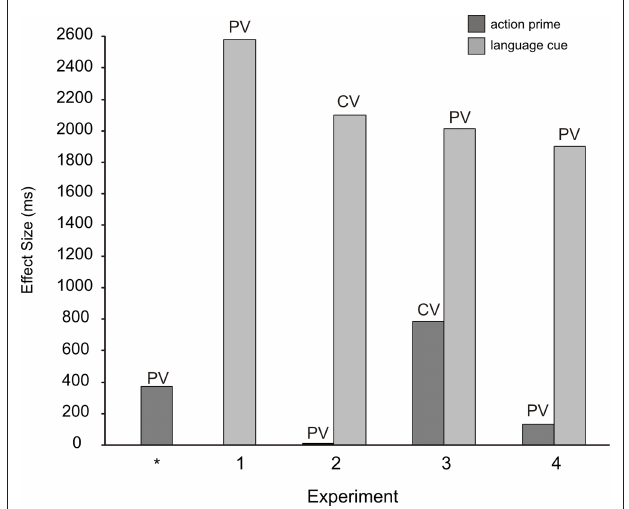
FigurE 2 | A summary graph of mean effect sizes (mean incongruent rTs − mean congruent rTs) across all experiments. PV, partially valid cue/ prime; CV, completely valid cue/prime; * refers to Symes et al. (2008, Experiment